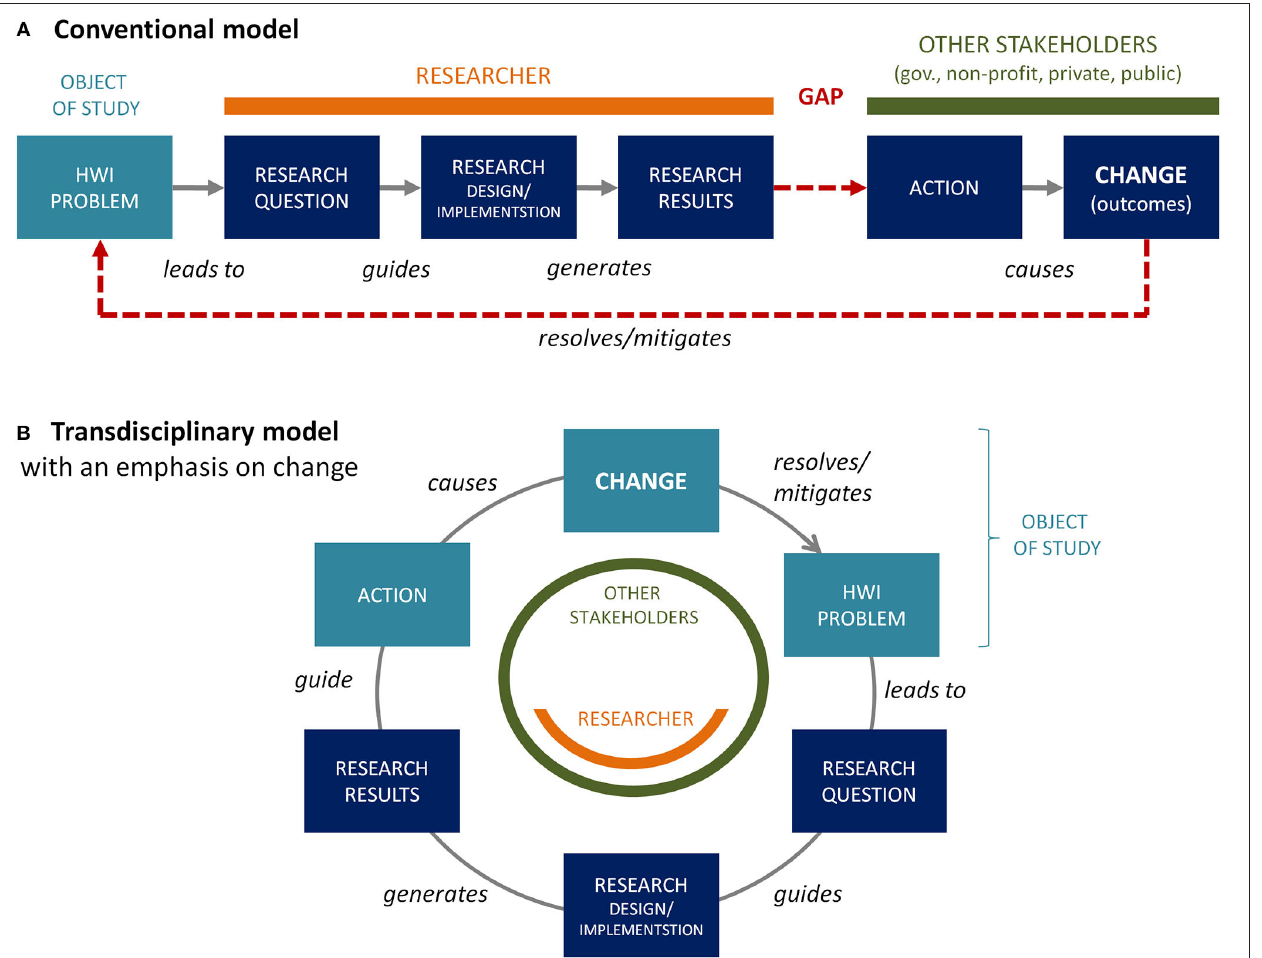
FIGURE 4 | Conventional (A) and alternative (B) models for the role of researchers and other stakeholders in tackling HWI problems. Dashed arrows represent the links that are typically weak or missing: the use of research results by decision makers and practitioners, and the monitoring and evaluation of the ultimate effects of actions on the HWI